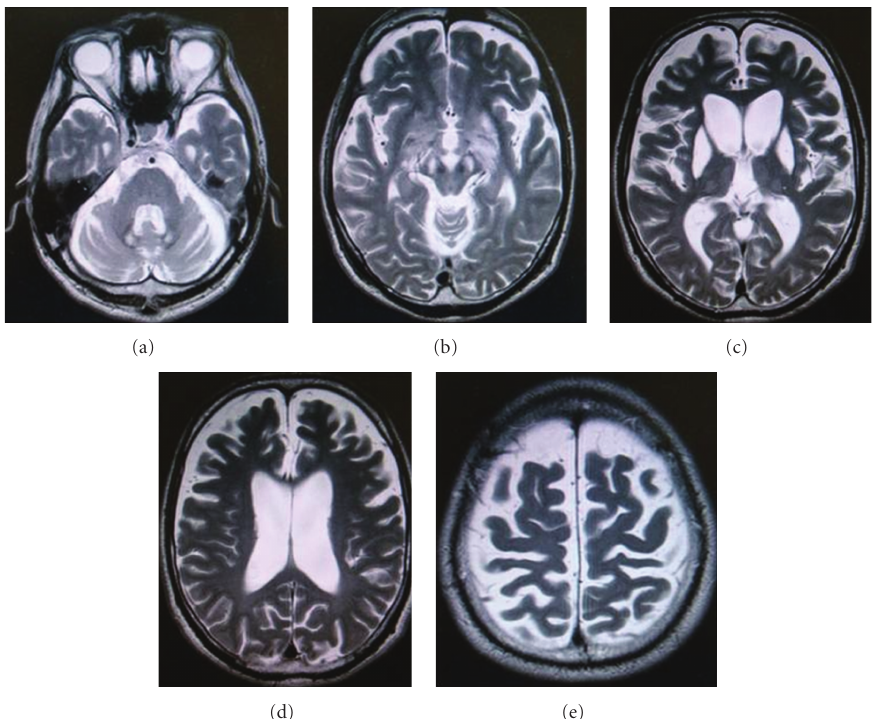
Figure 3: T2-weighted images (TR 3,440 msec/TE 89.4msec) at 42 years old. (a) A cross-section at the pontine level exhibits bilateral and symmetrical signal loss with central hyperintense abnormalities in the dentate nucleus with cerebeller cortical atrophy. (b) An image of a midbrain section demonstrates the symmetrical increased signal intensity involving the substantia nigra. A decreased signal change is observed in the red nucleus. (c) An image at the level of the basal ganglia shows hyperintensity with a band of surrounding hypointensity a ff ecting the putamen and pallidum. Foggy high signal changes can be seen in the inner part of the thalamus bilaterally. (d) An image of a section of the central part of the lateral ventricles. (e) An image of a section of the cerebral cortex. The signal change is not